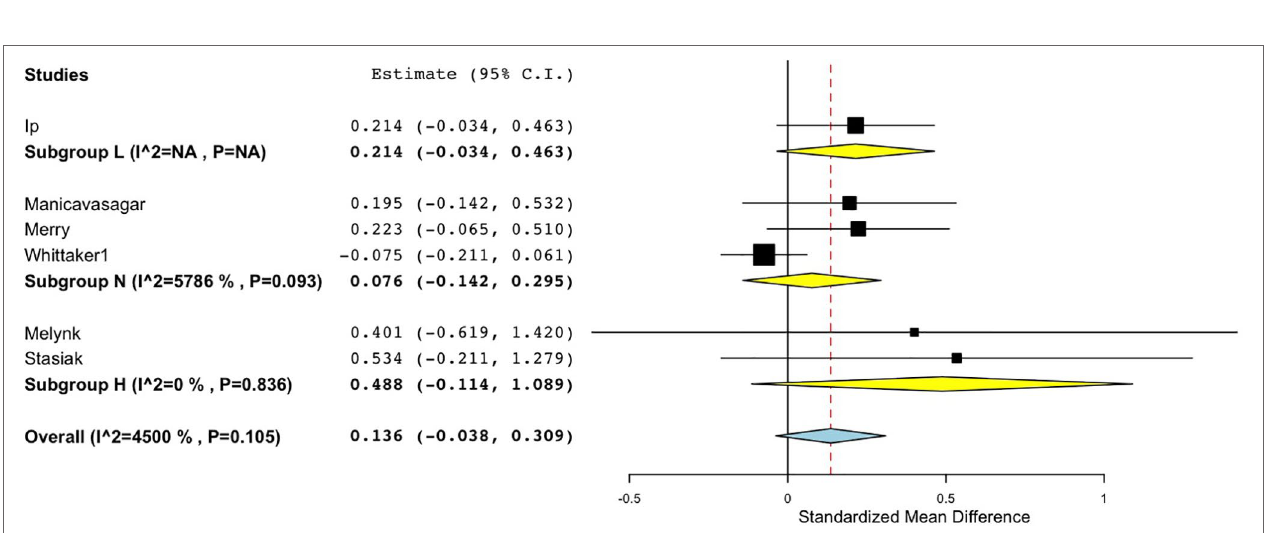
FIGURE 5 | Forest plot of sub-group analysis of Interaction level for randomised controlled comparisons between DMHIs with high, low and no support compared to active control groups for depression in